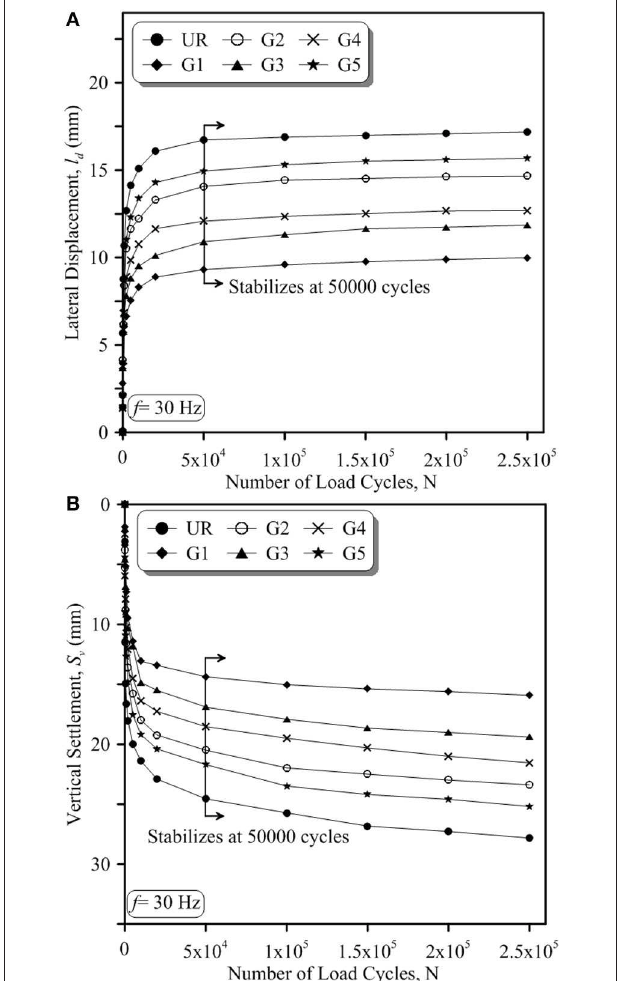
FIGURE 7 | Variation of (A) vertical settlement ( S v ) and (B) lateral displacement ( l d ) of unreinforced and geogrid-reinforced ballast with load cycles ( N